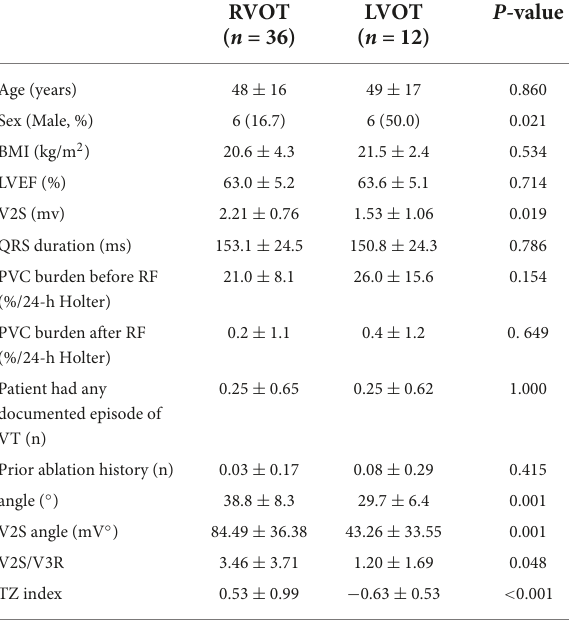
TABLE 5 Patient characteristics and electrocardiographic characteristics in the prospective cohort ( n =